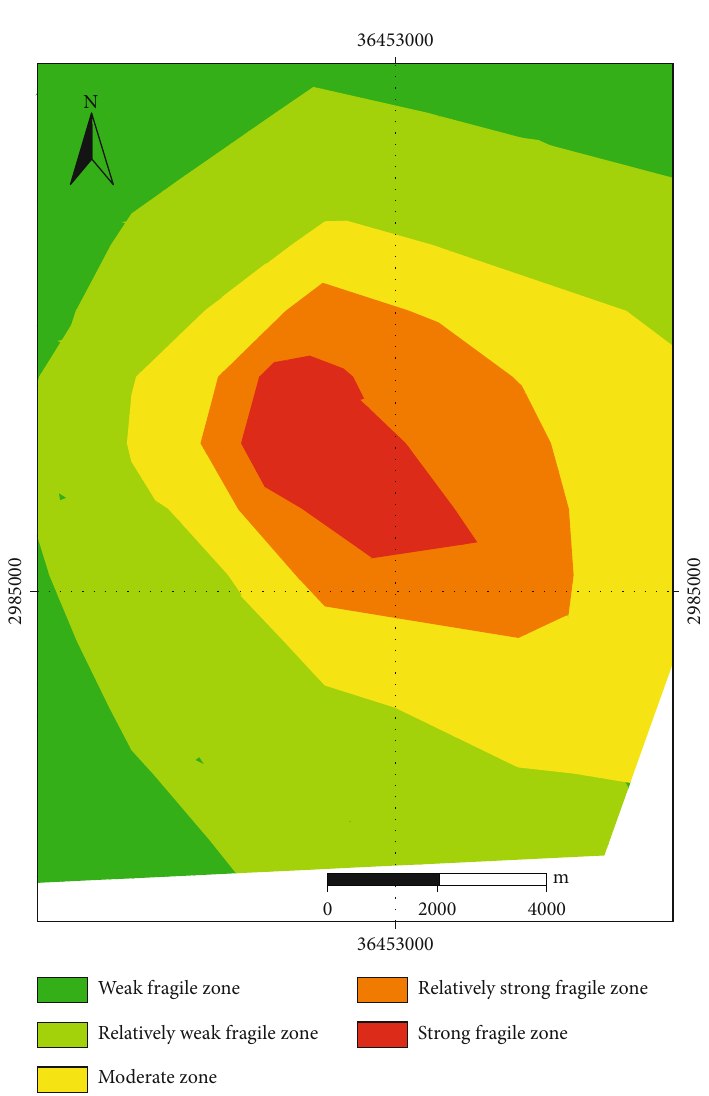
Figure 6: Partial enlarged map based on